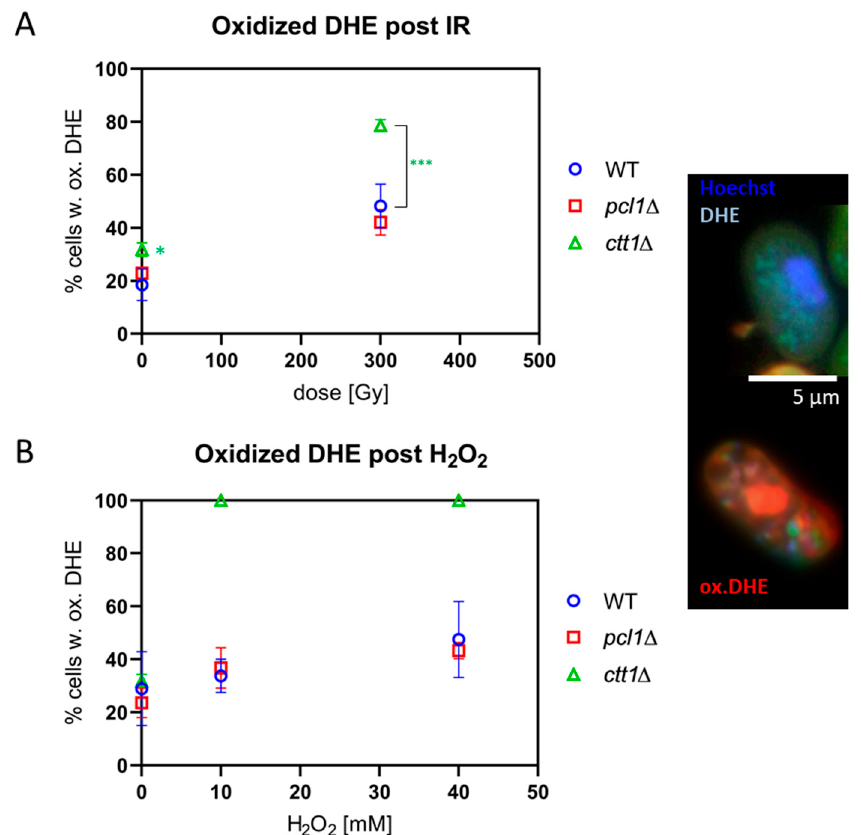
Figure 3. Formation of reactive oxygen species (ROS). ROS (preferentially superoxide) oxidize blue dihydroethidium to red ethidium (ox.DHE) as seen in the cells displayed to the right. Bar = 5 µ m. ( A ) Among the controls ctt1 ∆ cells showed a marginally significant elevated percentage of ox.DHE-positive cells (* p = 0.049). After 300 Gy, X ray-exposed WT and pcl1 ∆ meiocytes showed a significant increase in the average percentage cells with oxidized DHE ( p < 0.007) relative to sham control. For ctt1 ∆ meiocytes 300 Gy X IR induced an insignificant increase of the average percentage of ox. DHE meiocytes over sham, however, this increase at was highly significant (*** p < 0.0001) relative to IR-exposed WT and pcl1 ∆ meiocytes. ( B ) H 2 O 2 -induced ROS similarly increased the average percentage of ox.DHE-positive meiocytes in WT and pcl1 ∆ . ctt1 ∆ cells, on the other hand, were killed by H 2 O 2 , and all showed a positive signal for ox.DHE. The di ff erences among the controls were not significant. Data points reflect the mean of three experiments (±SD).